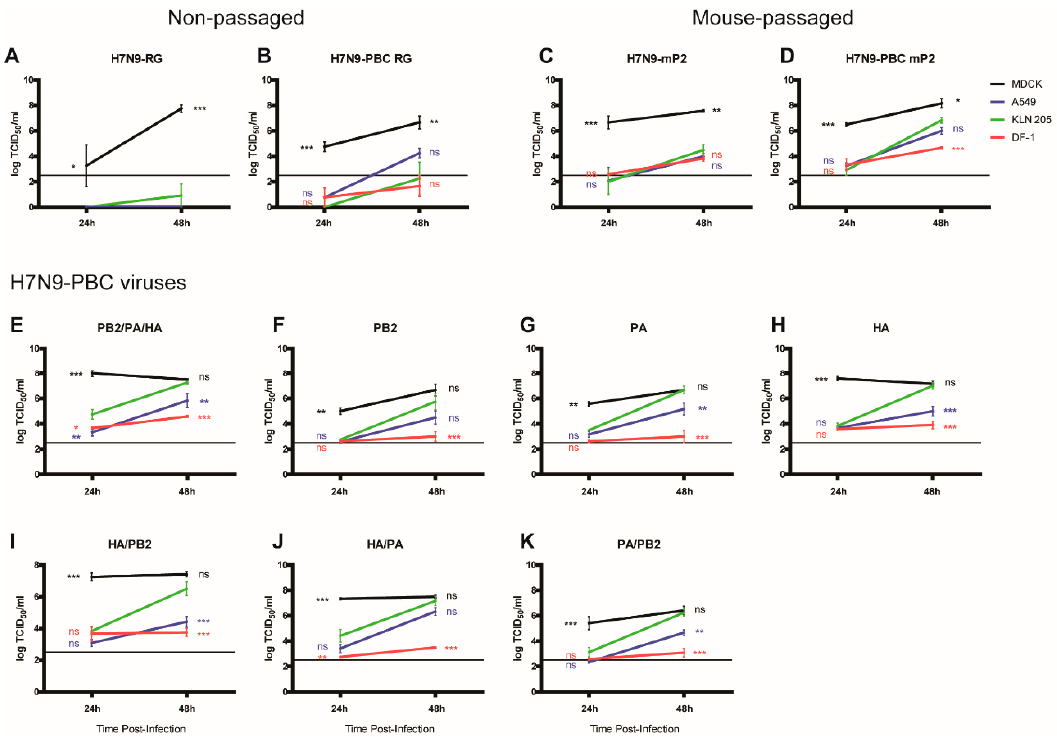
Figure 4. Growth of H7N9-PBC influenza viruses in mammalian cell lines. Viral replication was determined in Madin Darby Canine Kidney (MDCK), human lung (A549), mouse lung (KLN 205), and chicken fibroblast (DF-1) cell lines at 24 and 48 h post-infection with 0.5 µg/mL TPCK-trypsin supplemented into the culture medium. Viral titers were determined by TCID 50 assay using MDCK cells with 1.0 µg/mL TPCK-trypsin in the medium. Non-passaged ( A ) H7N9-RG and ( B ) H7N9-PBC RG viruses were compared to their respective mouse-passaged (mP2) versions, ( C ) H7N9-mP2 and ( D ) H7N9-PBC mP2. Replication was also determined for the reverse genetics engineered H7N9-PBC mP2 virus ( E , PB2/PA/HA), the recombinant H7N9-PBC viruses containing single mutations in ( F ) PB2, ( G ) PA, or ( H ) HA, or double mutations in ( I ) HA/PB2, ( J ) HA/PA, or ( K ) PA/PB2. Dotted line on each graph represents the limit of detection of the TCID 50 assay. Mean viral titers and standard error of mean are shown, two-way ANOVA with Bonferroni post-tests was performed comparing all results to KLN 205 at each time point, ns = not significant, * or ** or *** denotes p -values of < 0.05, or < 0.01, or < 0.001, respectively.